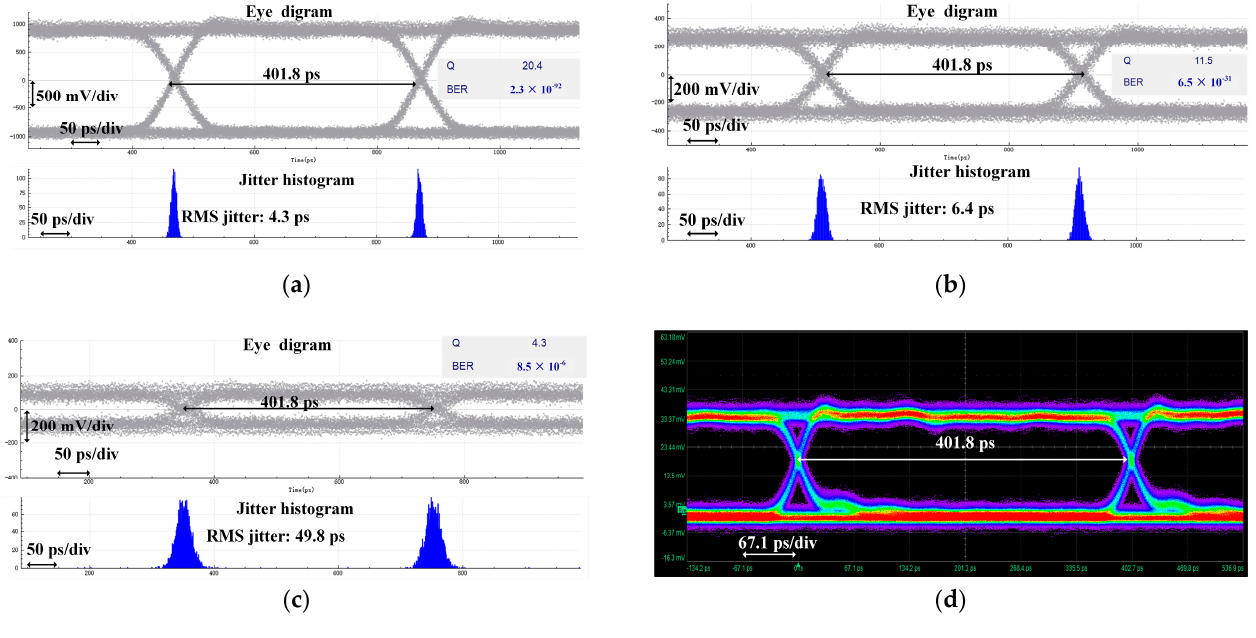
Figure 7. The measured eye diagrams and time jitter histograms when the optical signals under test from an optical transmitter (HUAWEI-2.5 GHz–80 km) have different powers of ( a ) − 10 dBm, ( b ) − 17 dBm, and ( c ) − 22 dBm. ( d ) The measured eye diagram by the commercial real-time oscilloscope. Table 1. Performance comparison of various eye diagram monitoring methods.